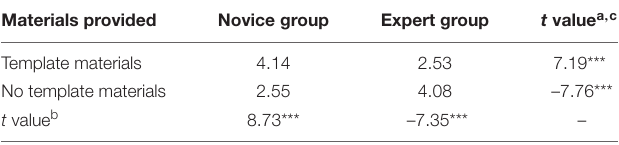
TABLE 7 | Manipulation check on materials provided.